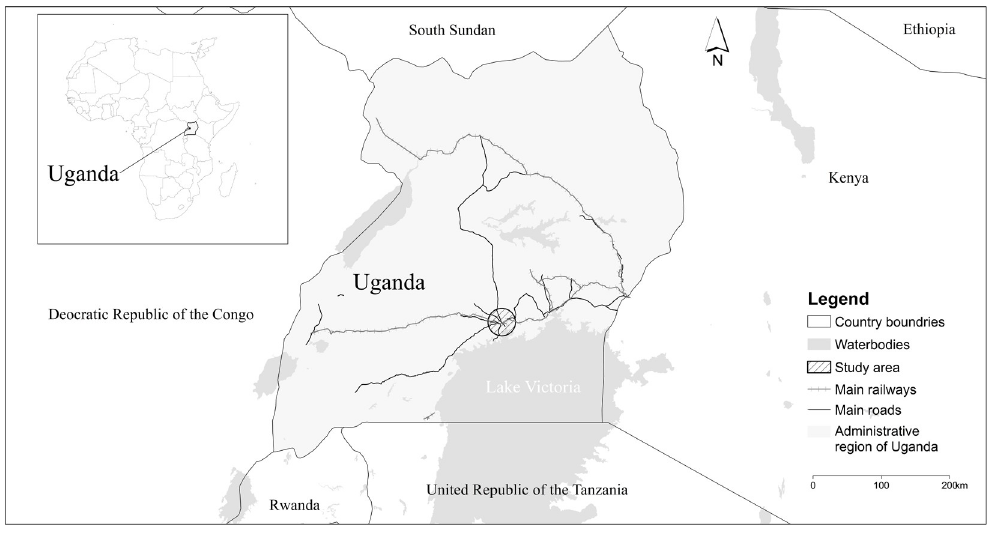
Fig 1. The location of Kampala in Uganda and